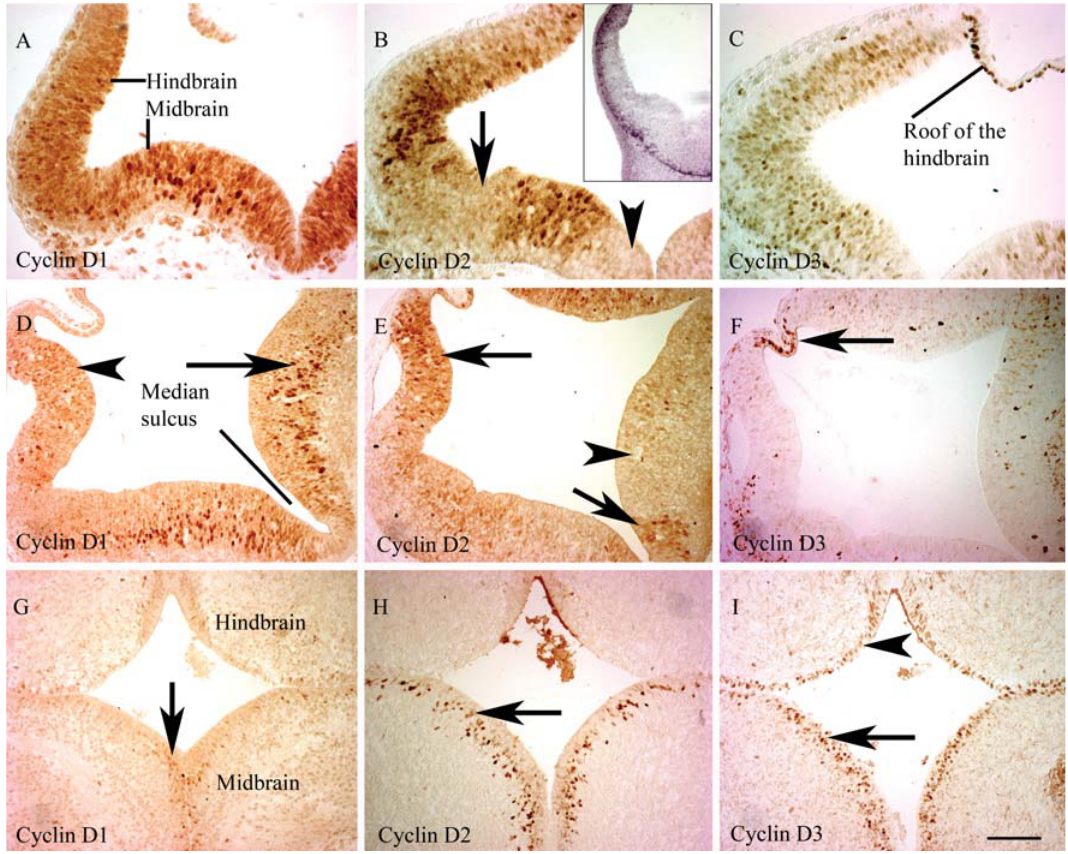
Figure 3 - Consecutive sections through the midbrain-hindbrain region at embryonic stages E10.5 (A-C), E12.5 (D-F) and E15.5 (G-I) showing colorimetricstainingofD-typecyclins.(A,D,G)CyclinD1proteinisdetectableincellsofallcyclephasesatE10.5(A),atstageE12.5mainlyinS-phase cells of the midbrain (B, arrow), at weak levels in cells of the hindbrain (D, arrowhead) and in few cells close to the median sulcus at stage E15.5 (G). (B) Cyclin D2 protein is not expressed in a region of the dorsal midbrain (arrow) and around the median sulcus whereas the RNA is present at equal levels in S-phasecellsofallregions(inlay).(E,H)AtstageE12.5cyclinD2isexpressedinthehindbrainandaroundthemediansulcus(E,arrows),itismissingin the dorsal midbrain (E, arrowhead) and is up-regulated in the midbrain at E15.5 (H, arrow). (C, F, I) The expression of cyclin D3 at stage E10.5 (C) is re- duced to the roof of the hindbrain at stage E12.5 (F) and present again in the whole midbrain-hindbrain region at stage E15.5 (I). Dorsal on the top; Ven- tral at the bottom. Scale bar: In I, 100 μ m for